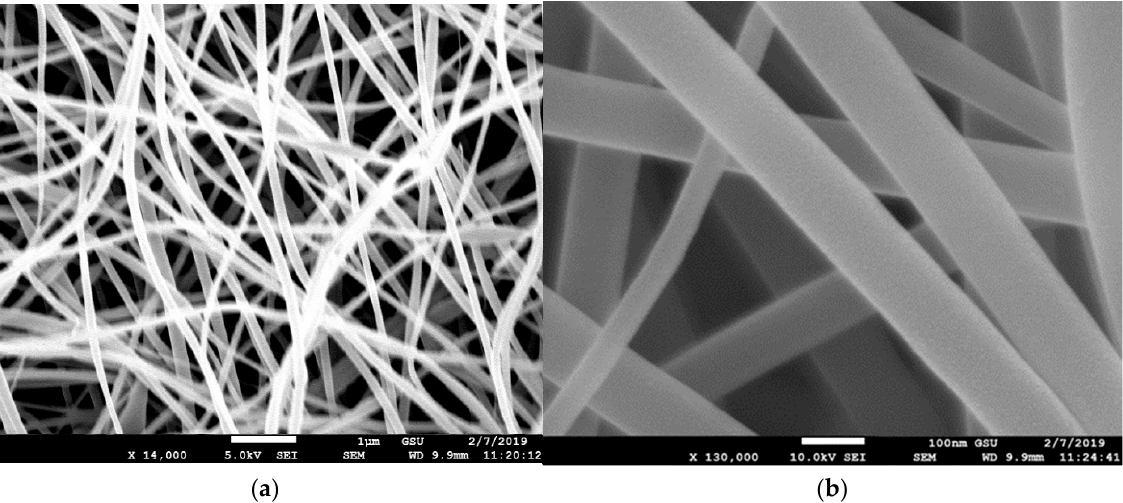
Figure 7. SEM image of pristine PAN nanofibers ( a ) at 14,000 magnification and ( b ) at 130,000 magnification.